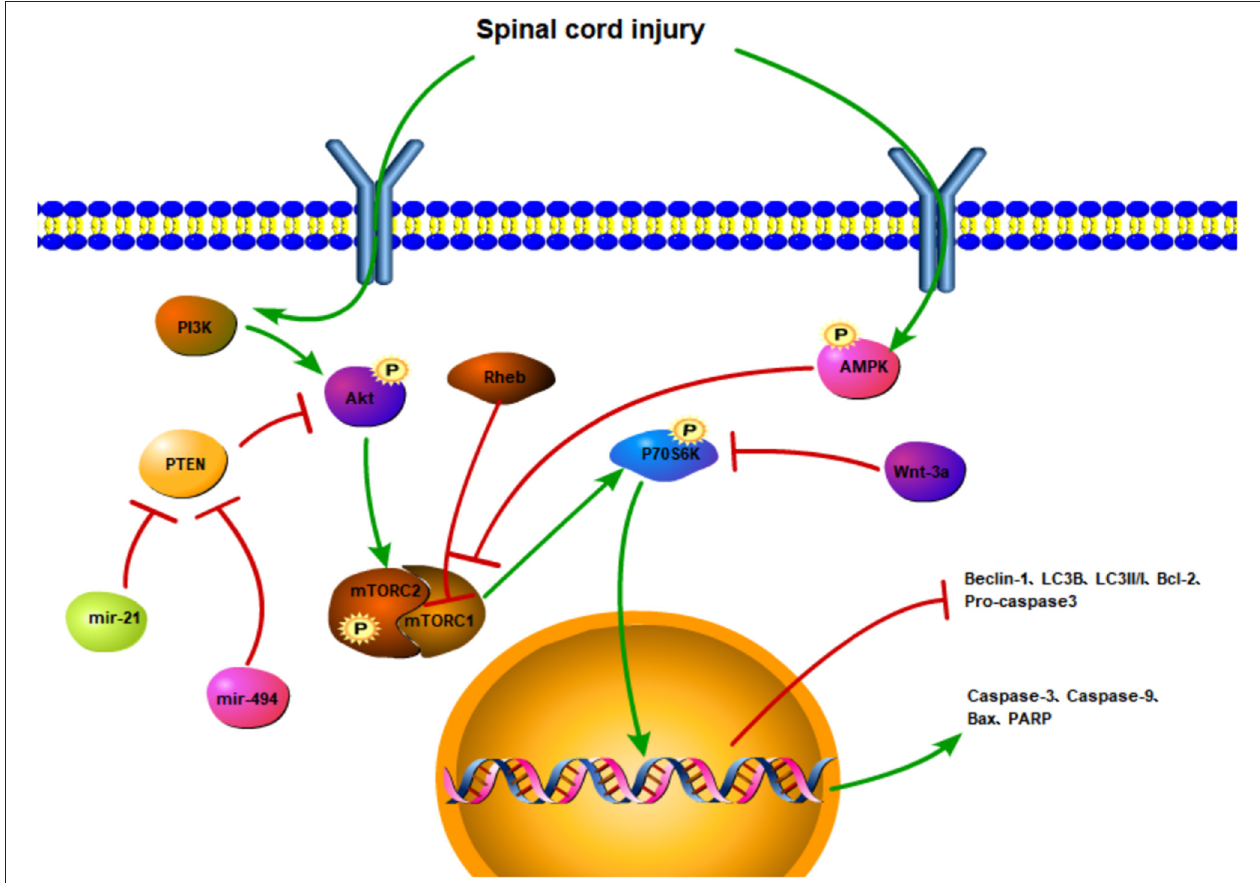
FIGURE 3 | The regulatory mechanism of the mTOR signaling pathway and apoptotic autophagy after spinal cord injury. SCI activates the PI3K/Akt signaling pathway and promotes the phosphorylation of the mTOR. The PTEN inhibits the phosphorylation of the Akt and triggers the mTOR. However, miR-21 and mir-494 may hinder PTEN activation. SCI promotes AMPK phosphorylation and inhibits mTOR activation. Rheb can also inhibit mTORC1. The activation of mTOR upregulates the expressions of P70S6K, caspase-3, caspase-9, Bax, and PARP and downregulates the expressions of Beclin-1, LC3II/I, LC3B, Bcl-2, procaspase 3. Wnt-3a inhibits the phosphorylation of